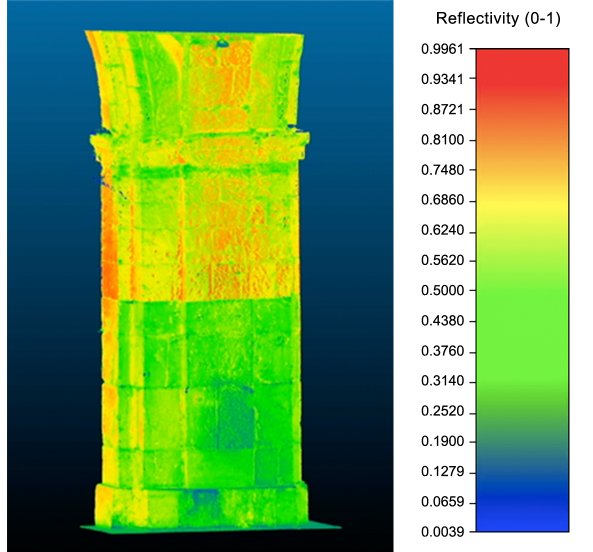
Figure 4. Reflectivity map of the pillar from TLS survey (elabo- rated with CloudCompare). The pillar was built with different stone materials: lower part with Pietra Forte, upper part with Pietra Can- tone.